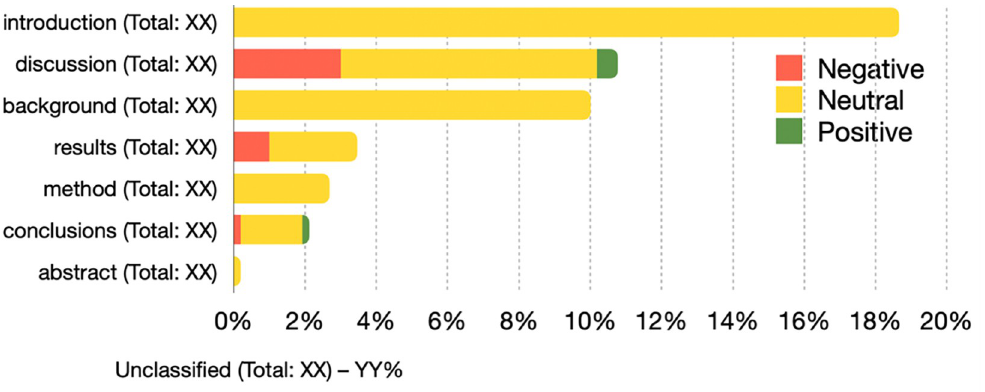
Fig 7. A horizontal bar chart representing the distribution of the in-text citations according to the section where they appear in. The graphic highlights the percentages of negative/neutral/positive in-text citations and mentions, between brackets, the total number on in-text citations annotated with such a section. The length (total percentage value) of the bars is in relation to the total number of in-text citation for the period in the PERIOD-SET shown by the graph and is used to sort the values of the